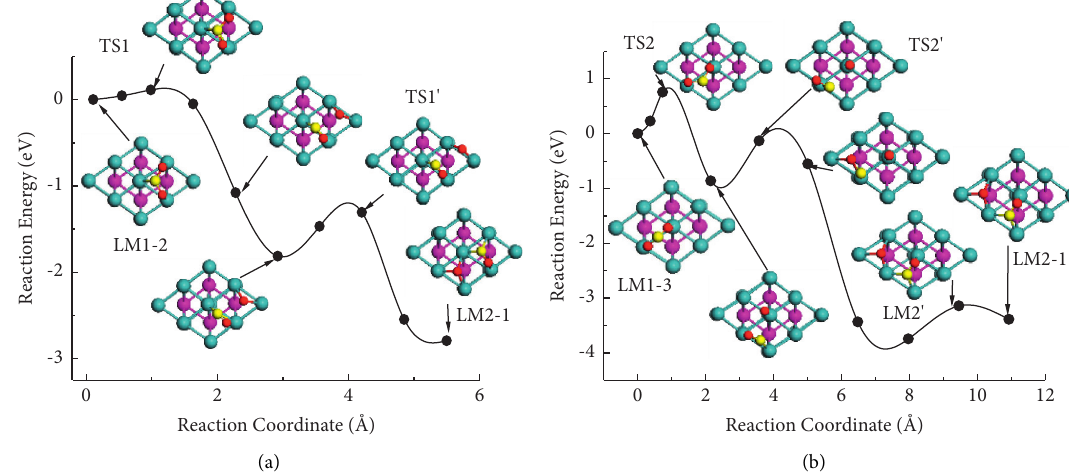
Figure 7: Potential energy surface of NO 2 molecule in the first step deoxidation process of Mo (110).